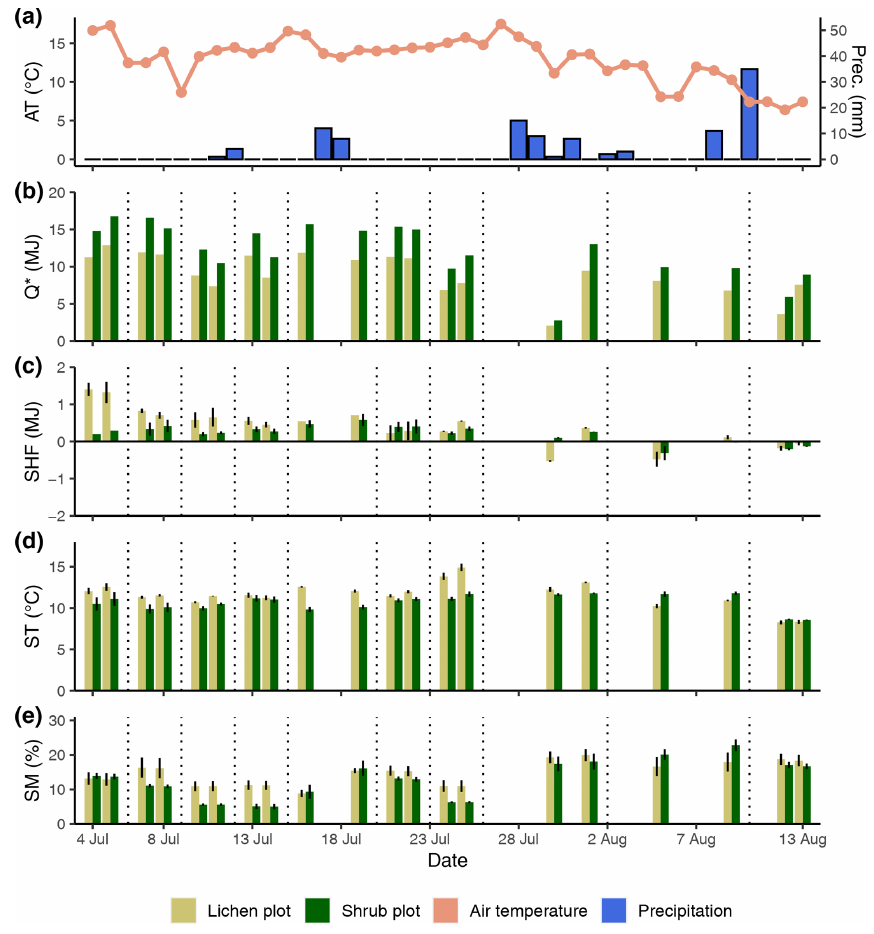
Figure 4. Daily measurements during the field season of 2018 for the background weather conditions (air temperature and precipita- tion) (a) , net radiation (b) , soil heat flux (c) , soil temperature (d) and soil moisture (e) . Every day is divided into the lichen and corresponding shrub plot for graphs (b) , (c) , (d) and (e) . For ease of display, we calculated averages per plot for the soil heat flux ( n = 2), soil temperature ( n = 3) and soil moisture ( n = 3). Error bars display minimum and maximum values for soil heat flux and standard errors for soil temperature and soil moisture. Vertical dotted lines indicate a plot